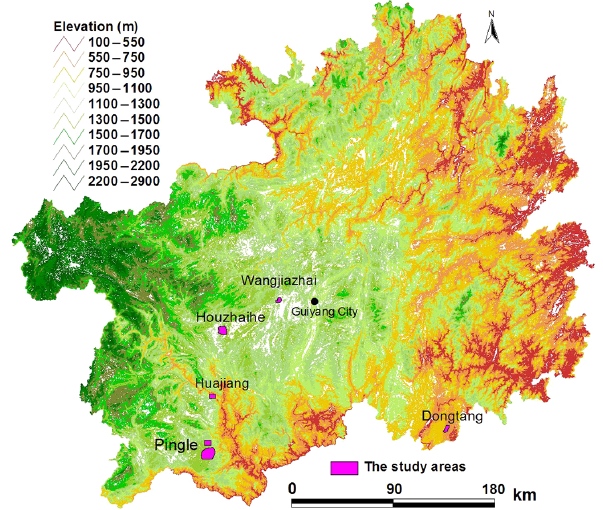
Figure 1. Distribution of the study